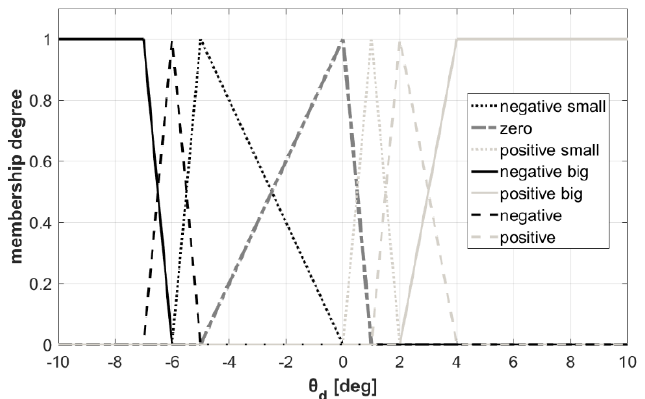
Figure 12. Membership degree of the output variable desired pitch angle θ d associated with fuzzy sets: positive big, positive, positive small, zero, negative small, negative, and negative big.